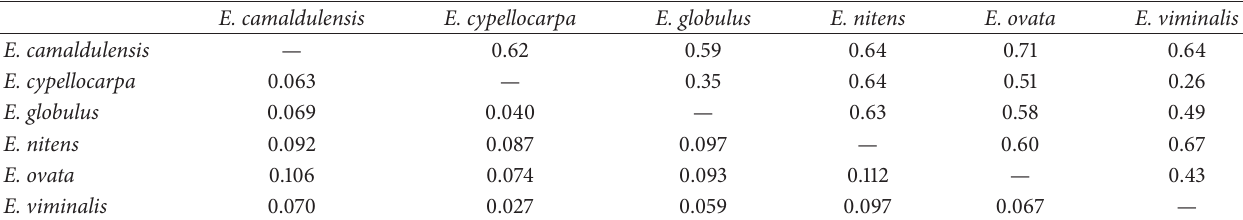
Table 2: Two measures of pairwise genetic differentiation between six eucalypt species genotyped at 10 microsatellite loci. Below the diagonal , and above is 𝐷 . All pairwise 𝐹 comparisons were significant at P < 0.0001 using is Wright’s 𝐹 ST EST ST